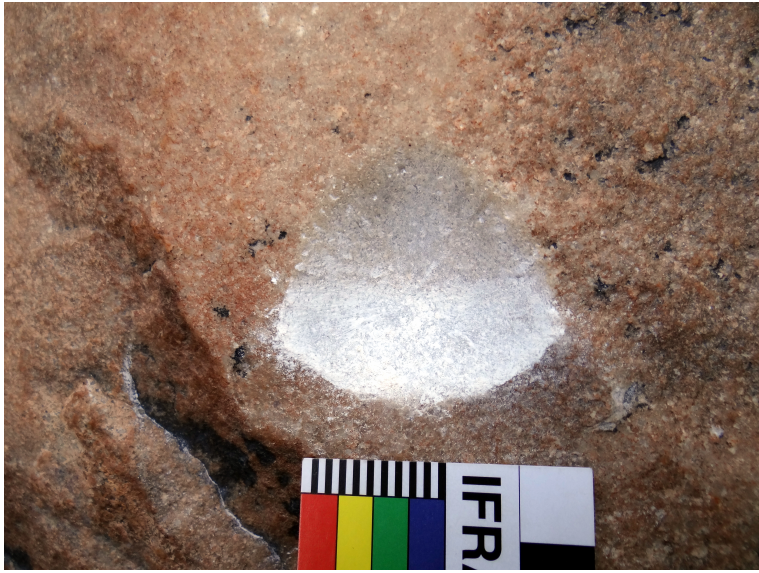
Figure 13. Replicated small cupule with conical depth, RC-9.